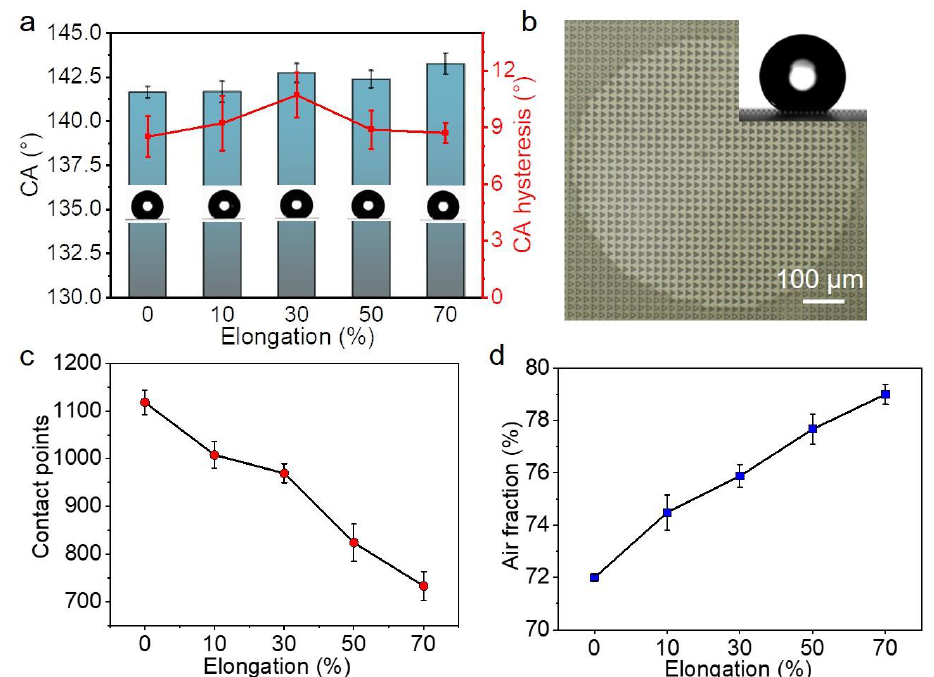
Figure 3. Wettability characterization by water contact angle (CA). ( a ) CA and CA hysteresis of ATM at various stretching ratios; ( b ) Typical optical image of the contact interface, the inset is a typical image of CA measurement; ( c , d ) The dependence of ( c ) contact points and ( d ) air fraction on the stretching ratio of ATM. Each data point in ( a , c , d ) represents the mean value of at least five measurements. Standard deviations are indicated by error bars.